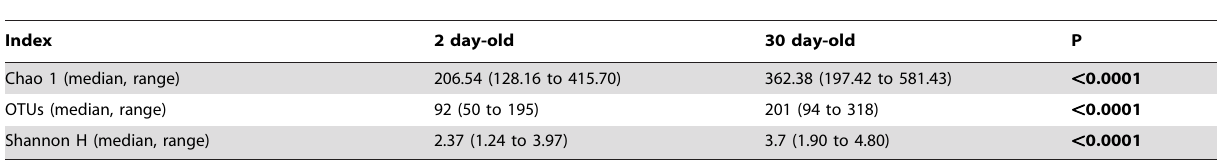
Table 4. Summary of alpha diversity measures.